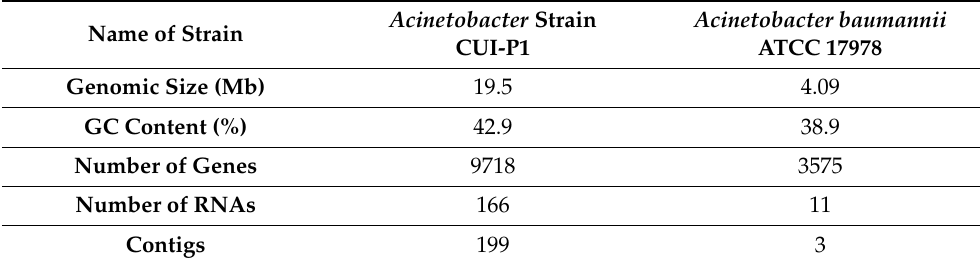
Table 3. Genomic feature of Acinetobacter strain CUI-P1.